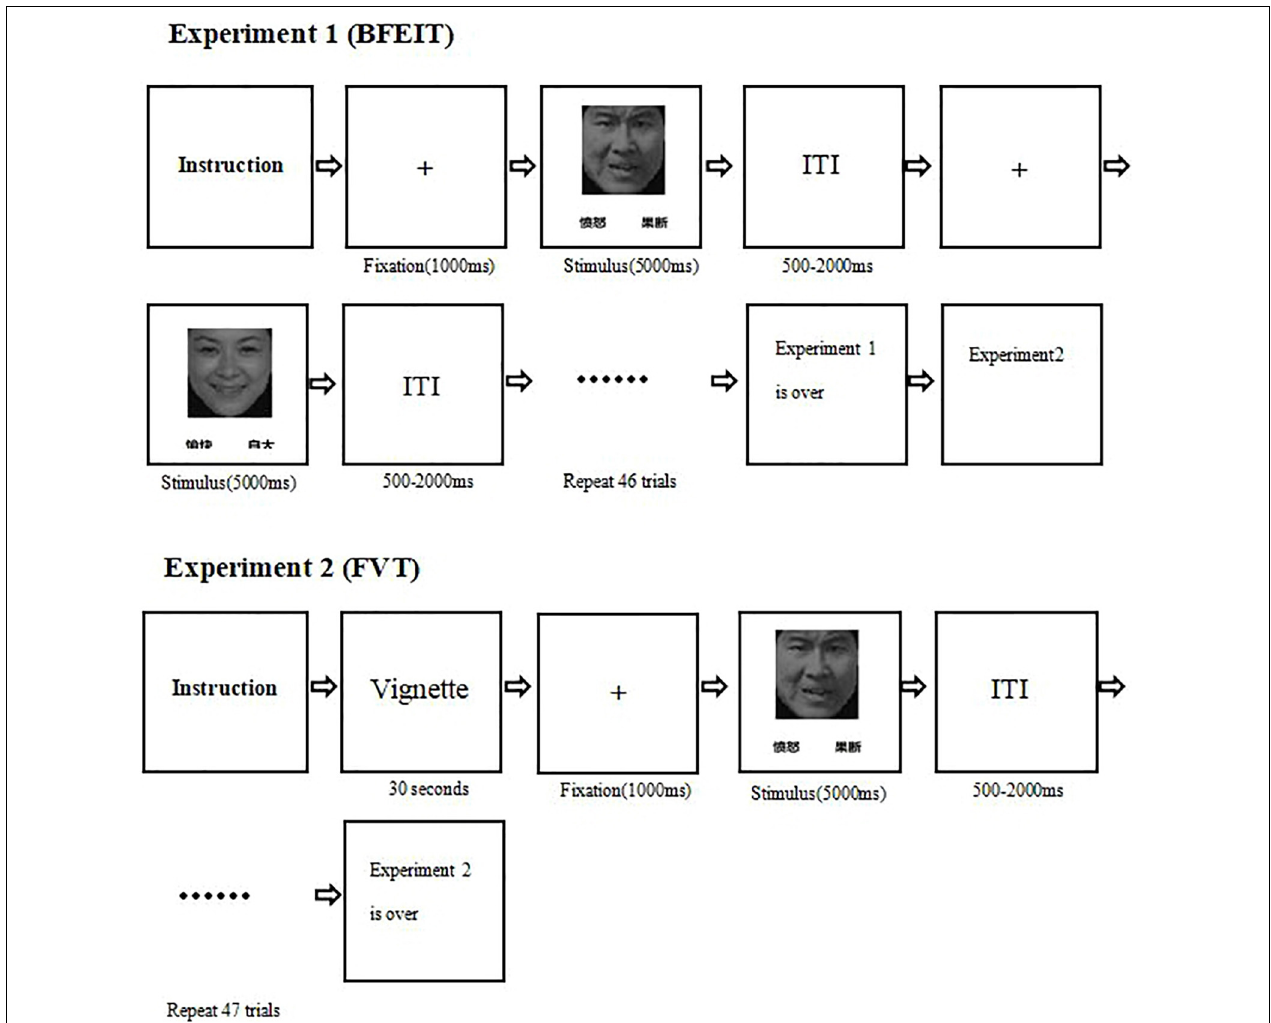
FIGURE 1 | A diagram illustrating the experimental procedures (experiment 1: the measurement of the basic facial emotion identification test; experiment 2: the measurement of the face-vignette